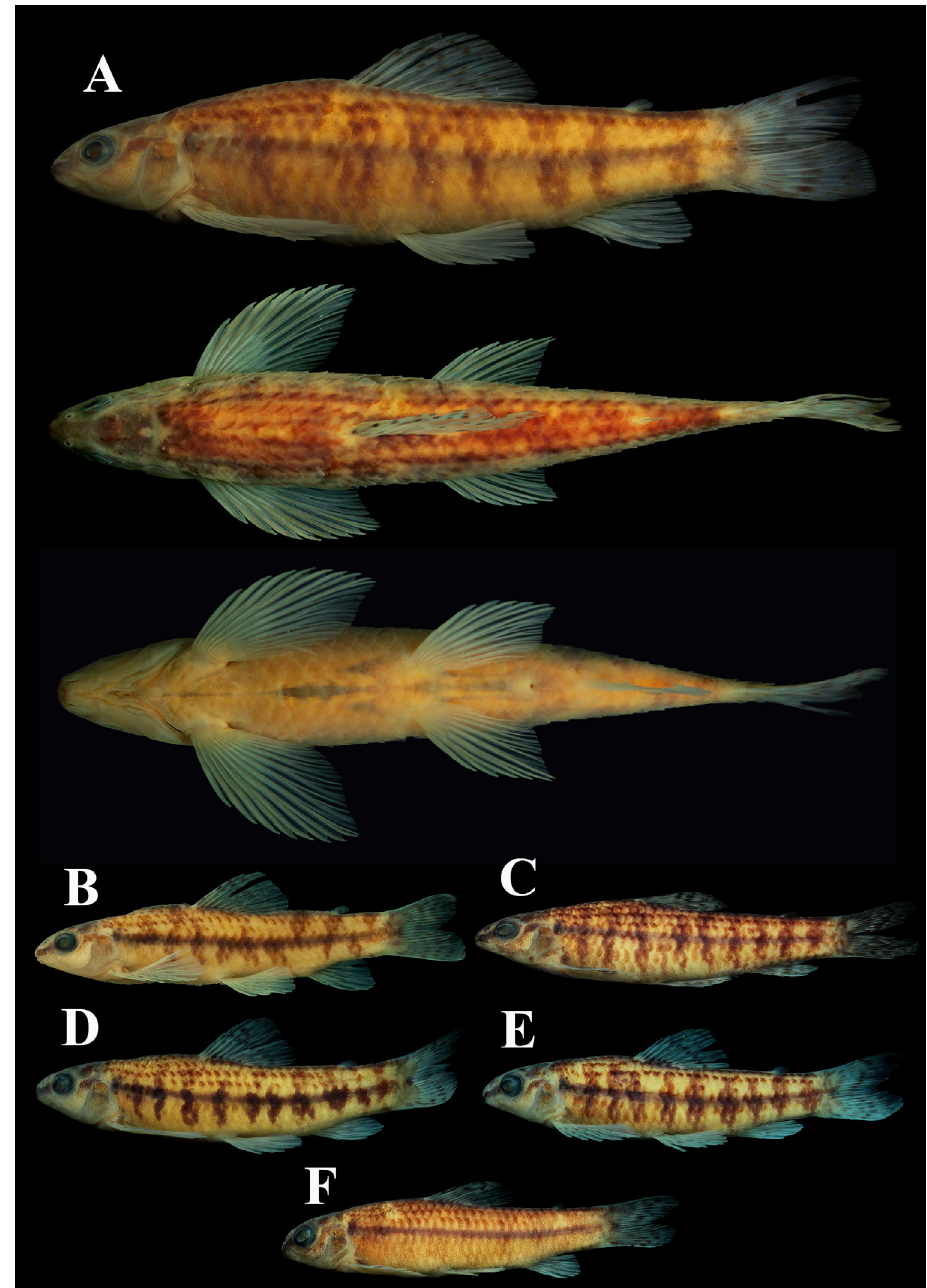
FIGURE 1 | Characidium krenak : A. holotype, MZUSP 125896, 57.6 mm SL. B. paratype, MZUSP 112284,